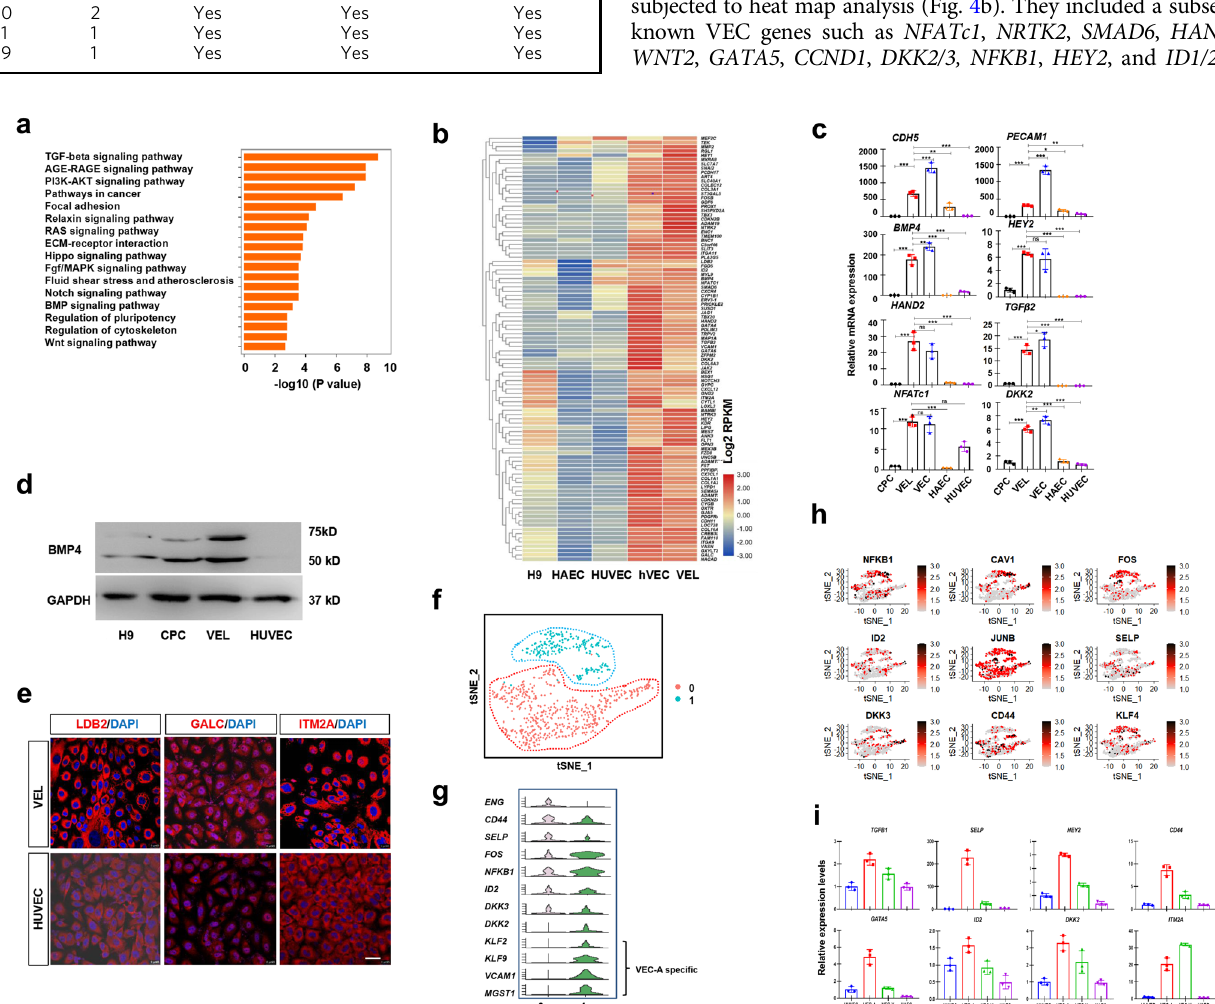
Fig. 4 Transcriptome comparison between the VELs and the primary VECs. a KEGG analysis of the shared genes between the VELs and the primary VECs, showing the enrichment of TGF- β , WNT, BMP, and NOTCH signaling pathways. b Heat map analysis showing that the majority of top 100 genes were highly expressed in the primary VECs and hPSC-derived VELs, but lowly in HAEC/HUVEC. c Validation of the indicated genes by qRT-PCR analysis. d WB results showing that BMP4 was expressed at much higher levels in day 7 hPSC-derived VELs than HUVEC. e IF staining results showing that the indicated markers were expressed at higher levels in day 7 hPSC-derived VELs than in HUVEC. Scale bar: 100 μ m. f The t-SNE map showing the second- level clustering of VECs into two subpopulations, designated as 0 and 1. g Violin plots showing the expression of indicated genes for subcluster 0 and 1, suggesting that subcluster 0 may represent ventricular side speci fi c VECs and subcluster 1 may represent aortic side speci fi c VECs. h tSNE maps showing that the indicated marker genes were indeed highly expressed in the VEC subclusters. i qRT-PCR results showing that the indicated genes were expressed much higher in VECs than HAEC and HUVEC. VEC-A and VEC-V represent the aortic and the ventricular side of VECs, respectively. The paired t test in Graphpad software was used for the statistical analysis. Signi fi cant levels are: * p < 0.05; ** P < 0.01; *** P <